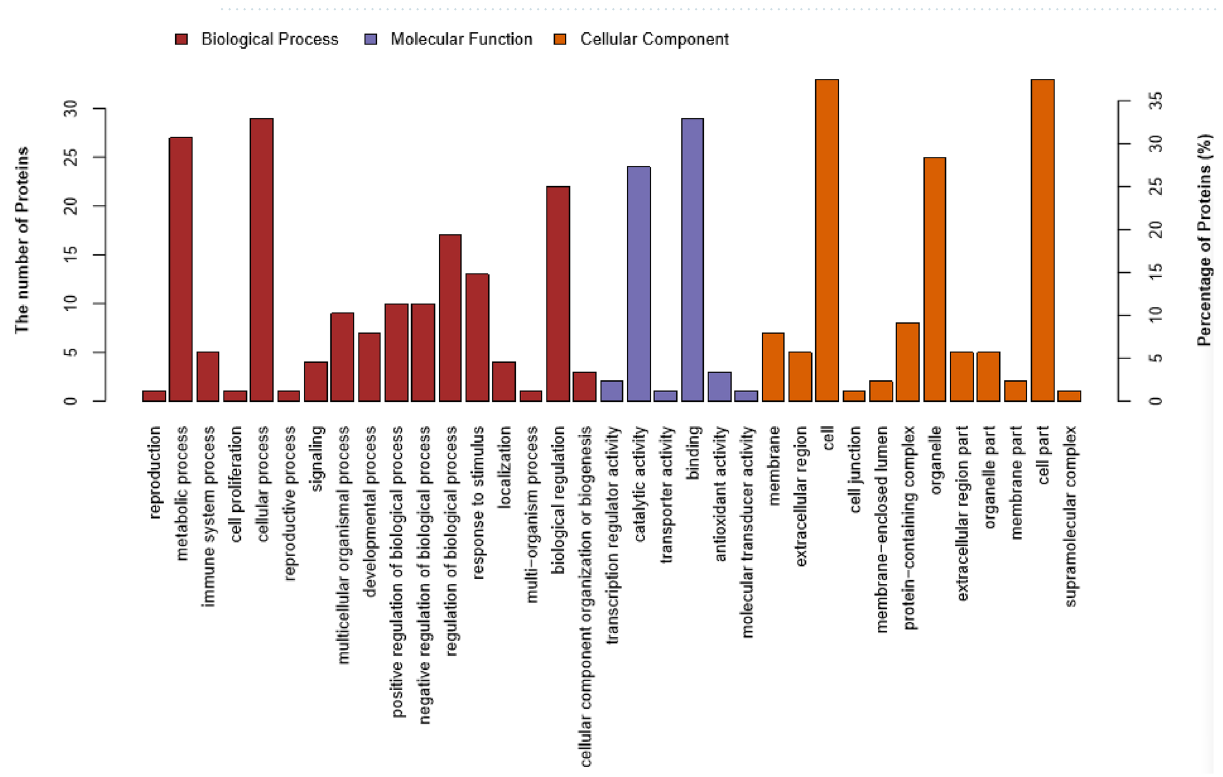
Figure 3. Function categorization of the acquired clones by GO analysis. GO analysis of the screened 17K-interacting genes. The genes were divided into three categories: cellular component, biological process, and molecular function